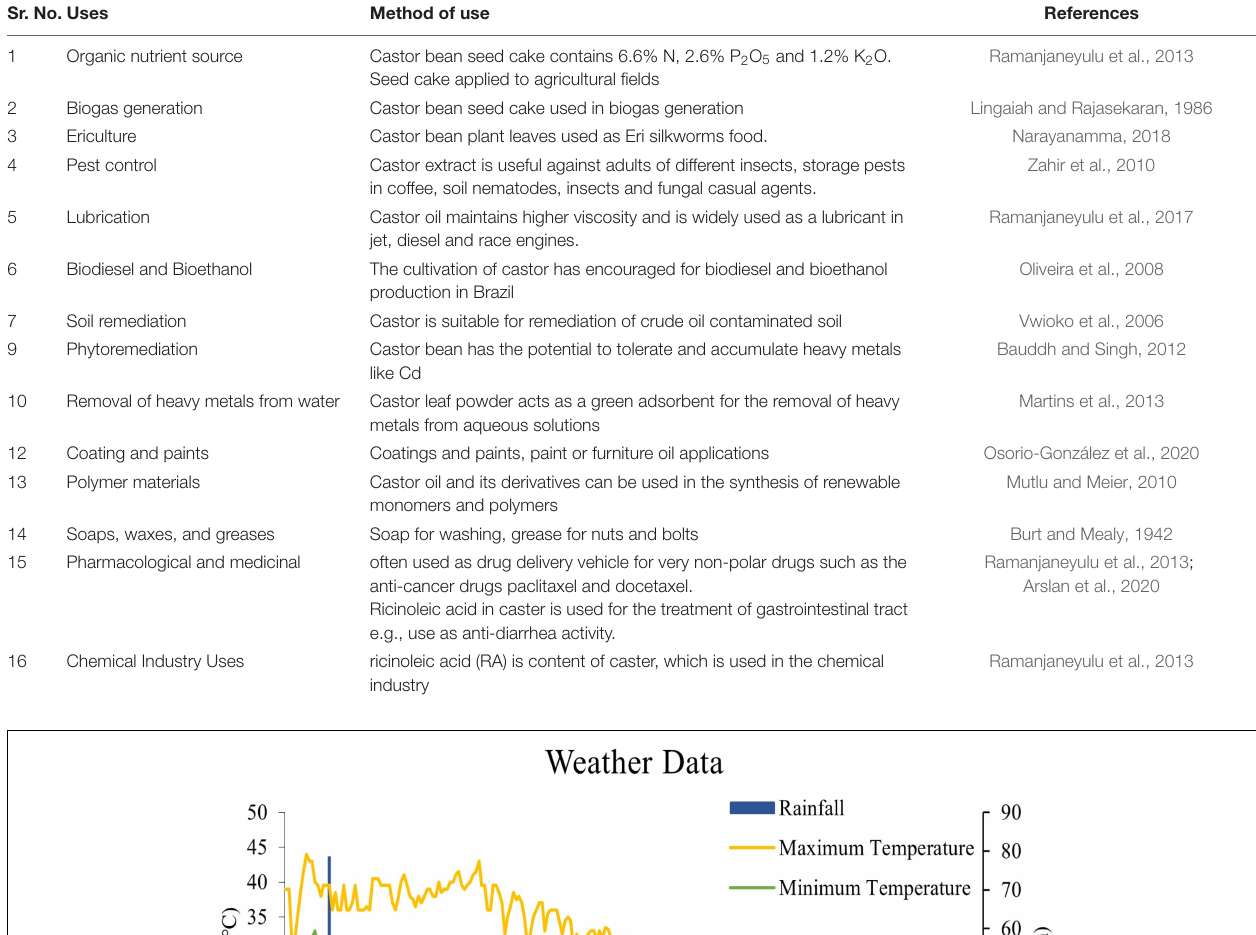
TABLE 1 | Various uses of castor bean and its products. Sr. No. Uses